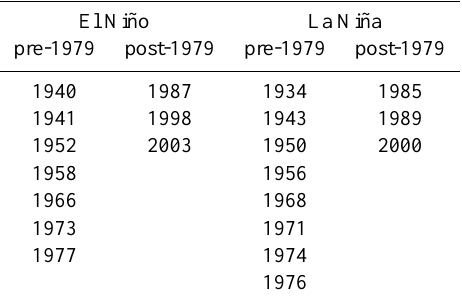
Table 1. Selection of Strong El Niño and La Niña winters (January– March) following Brönnimann et al.